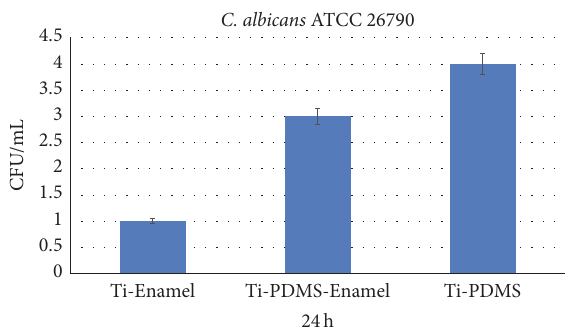
Figure 6: Graphic representation of the absorbance values of C. albicans ATCC 26790 biofilm cells developed on the Ti-Enamel, Ti- PDMS-Enamel, and Ti-PDMS